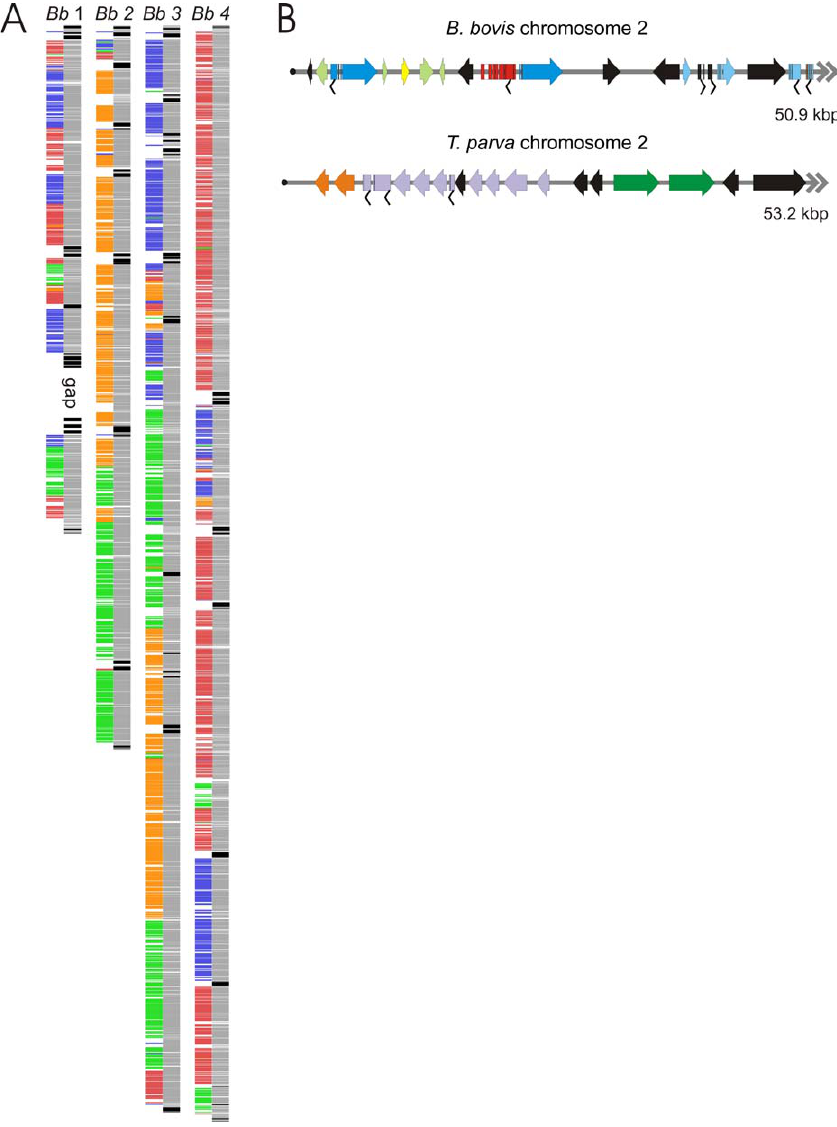
Figure 4. Diagram of Chromosomal Synteny between B. bovis and T. parva (A) Synteny at the chromosomal level. B. bovis chromosome number is indicated at the top. Bars on the right side of each chromosome diagram designate B. bovis genes, with black bars indicating B. bovis ves1 genes and gray bars indicating other genes. The colors on the left of each chromosome diagram indicate to which T. parva chromosome an ortholog belongs as follows: Tp1 ¼ red, Tp2 ¼ green, Tp3 ¼ blue, Tp4 ¼ orange. (B) Comparison of telomeric arrangement of genes for B. bovis and T. parva chromosome 2. The gray line indicates the chromosomal backbone, with black dots indicating the telomere. Large genes are depicted as arrows with coding direction indicated, while small genes have an arrowhead beneath the gene to indicate the direction of transcription. Gray double arrowheads indicate that the chromosome continues. Colors indicate gene content as follows: blue ¼ B. bovis ves1 a , red ¼ B. bovis ves1 b , yellow ¼ B. bovis SmORF, pale green ¼ putative membrane protein, pale blue ¼ annotated genes with predicted function, black ¼ hypothetical, orange ¼ T. parva family 3 hypothetical, purple ¼ T. parva family 1 hypothetical, green ¼ ABC